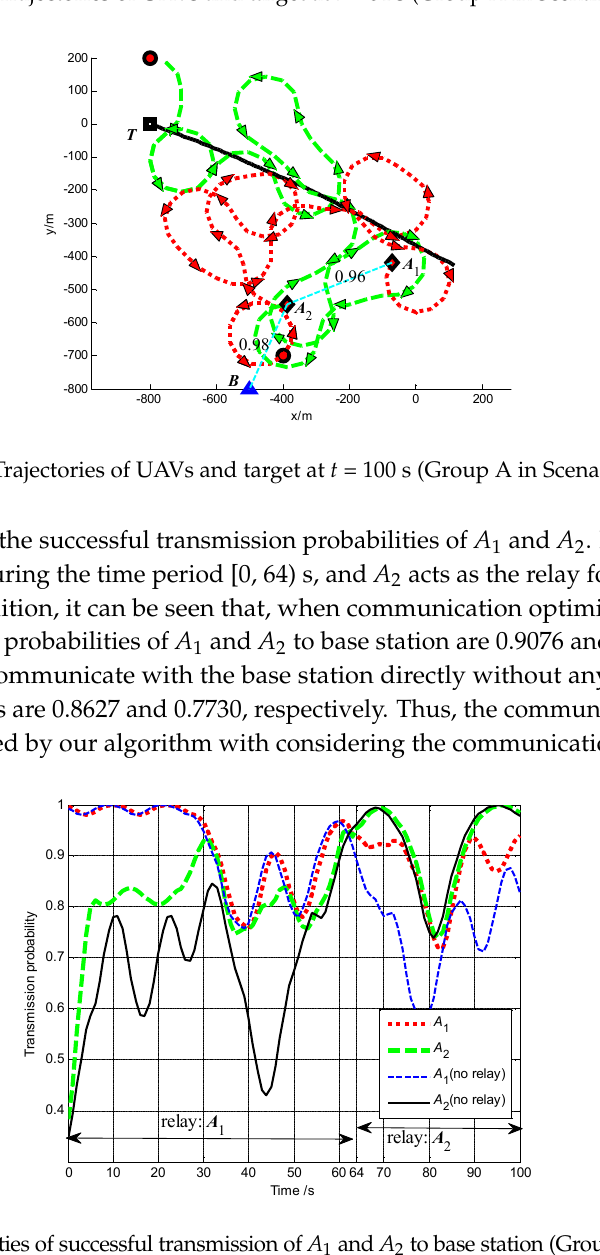
Distance Collision Figure 11. The distance between the UAVs during the simulation process (Group A in Scenario 1).